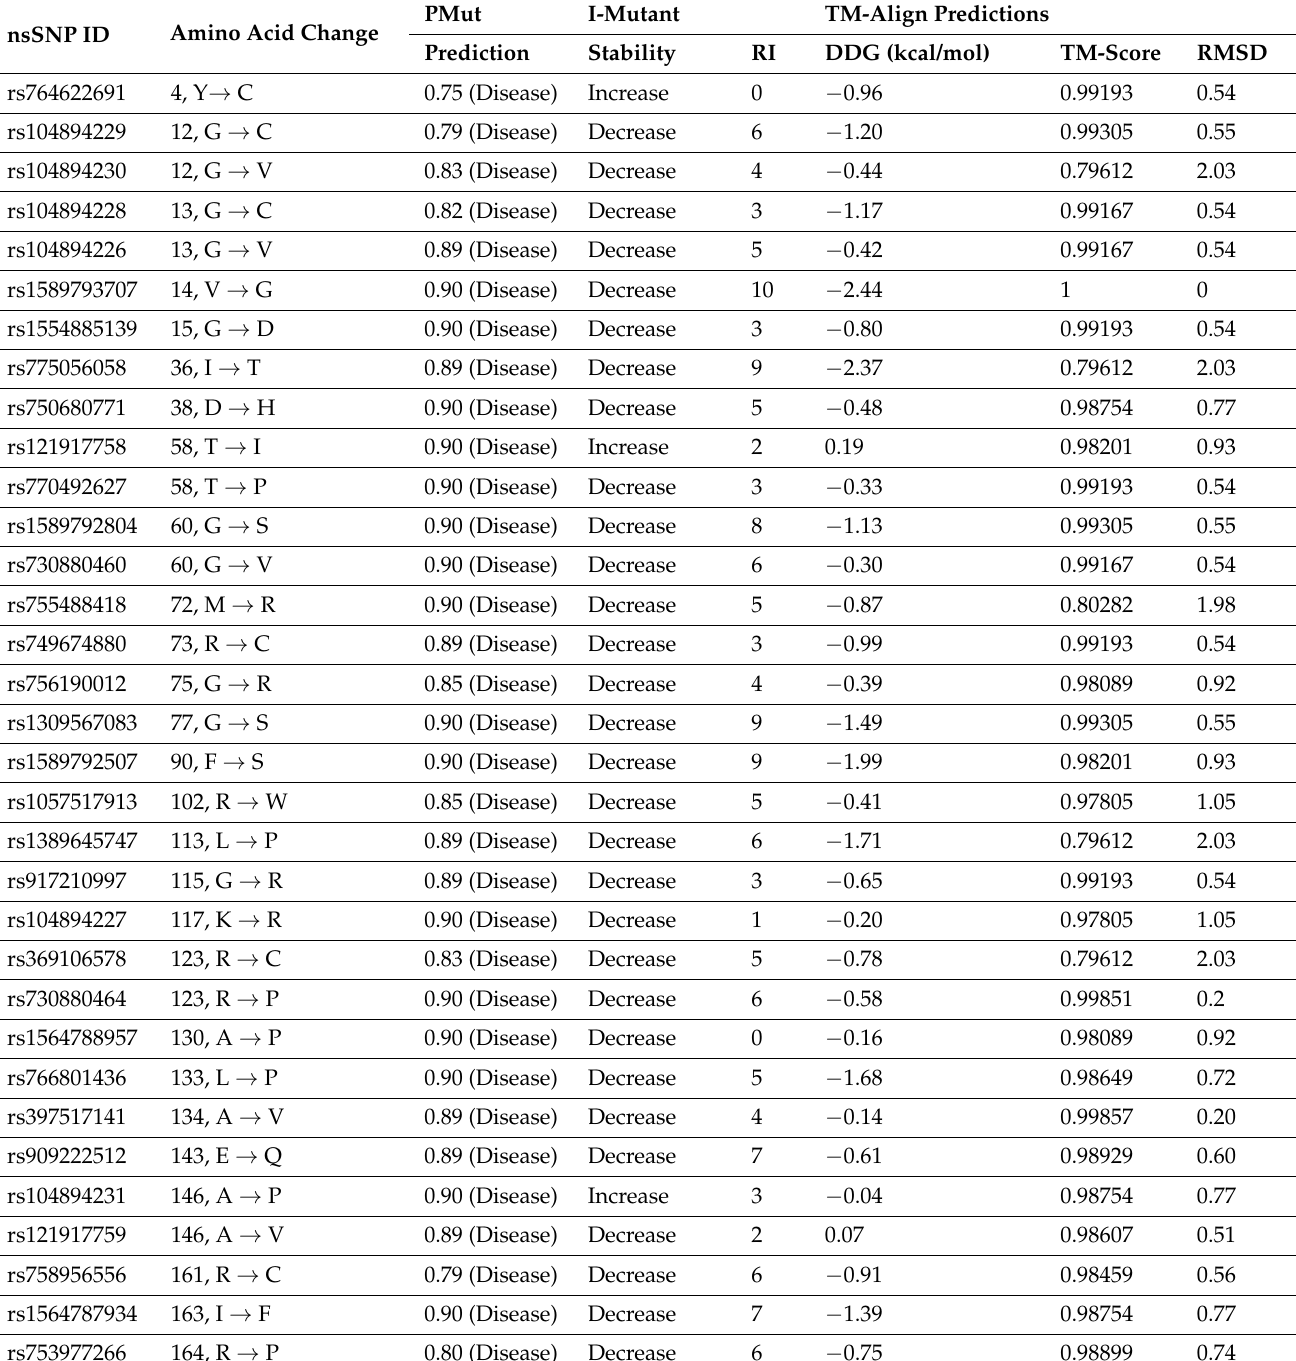
Table 2. P-Mut, I-Mutant, and TM-align predictions for deleterious